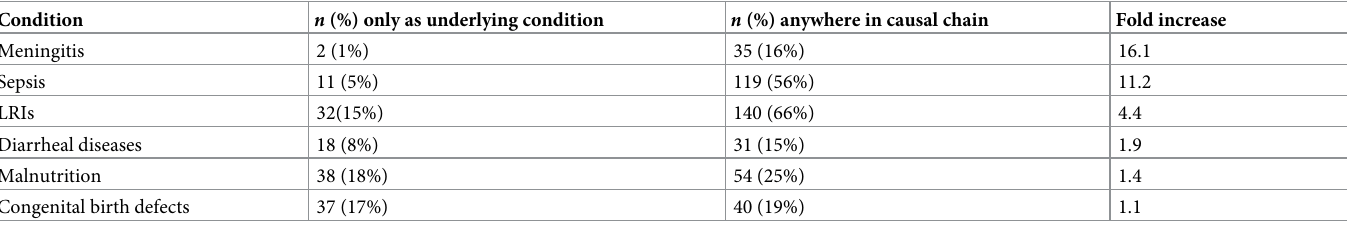
CoD, cause of death; LRI, lower respiratory